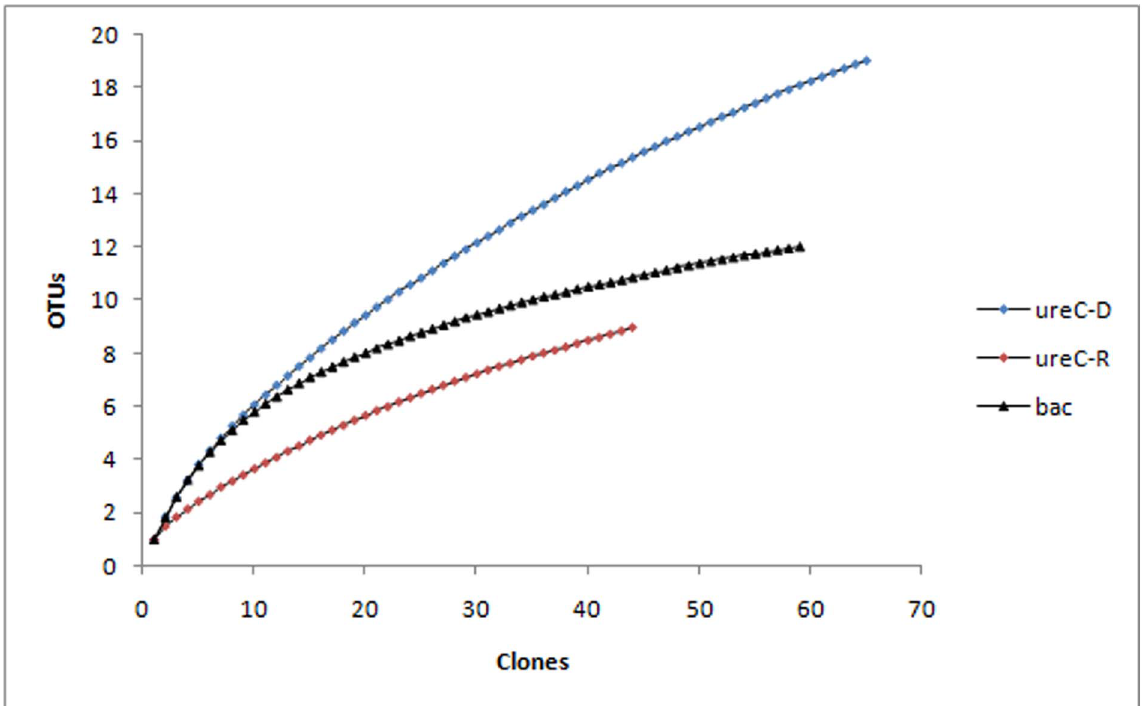
Figure 2. Rarefaction curves of ure C and 16S rRNA gene sequences. (Clusterization stringency at 90% and 97% for ure C and 16S rRNA gene,